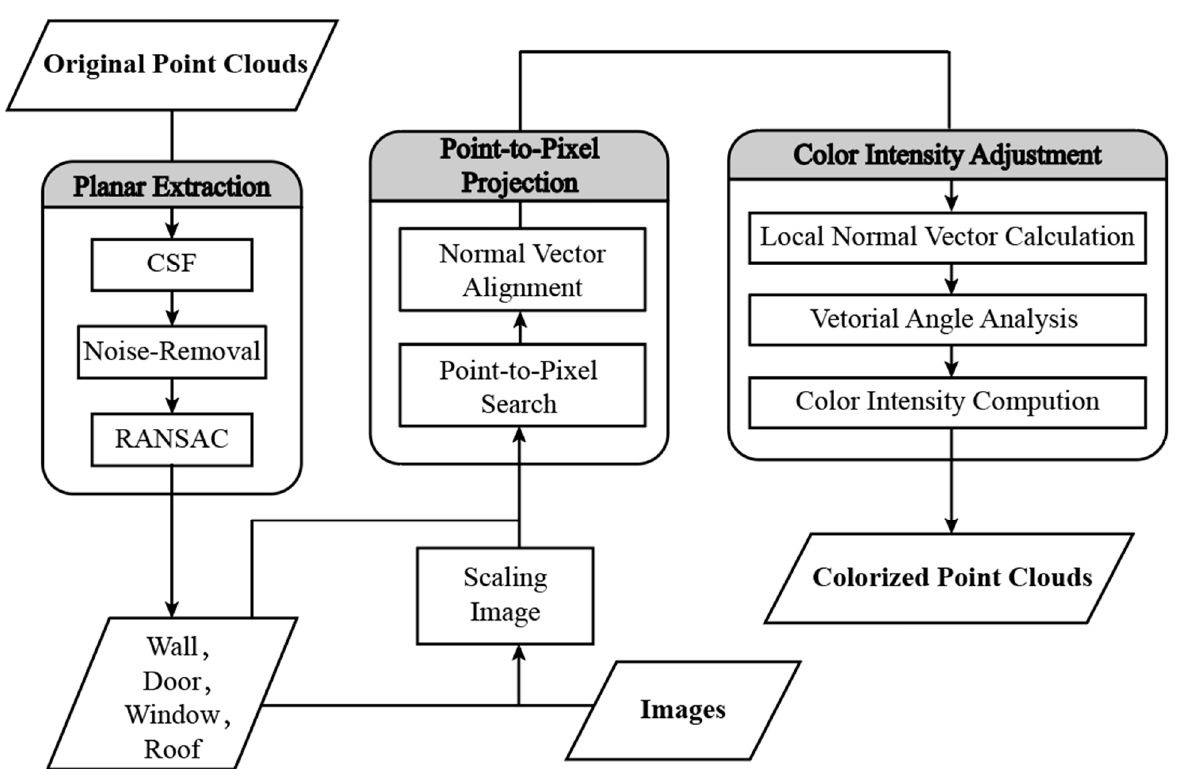
Figure 3. Workflow of the proposed method.